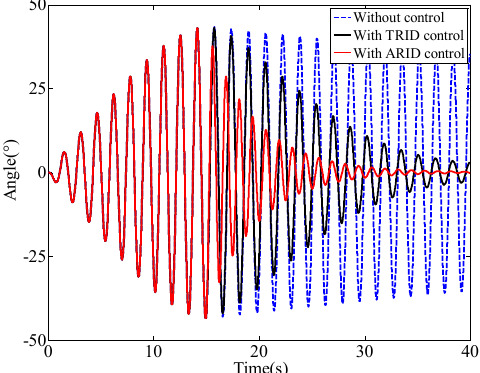
Figure 6. Numerical results of the swing angle of the structure with the TRID or ARID system.